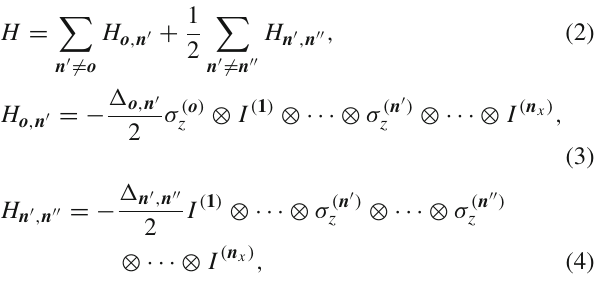
Fig. 1 Schematic representation. The arrangement of environmental particles in two-dimensional polar coordinates ( x is the number of branches of the rays, and here we take x = 6 as an example). The central system massive particle with mass m o is placed at polar coordi- nates (0, 0), while the environmental particle at coordinate position n (cid:2) with mass m n (cid:2) is placed at coordinates ( jr ,θ) (1 ≤ j ≤ N , N is the number of environmental particles in each ray branch, r is the distance between the adjacent particles in each ray. The coordinate of the first particle to the right of m o is fixed at ( r , 0 ) . In addition, the total num- ber of environmental particles n x = Nx . This figure shows that each